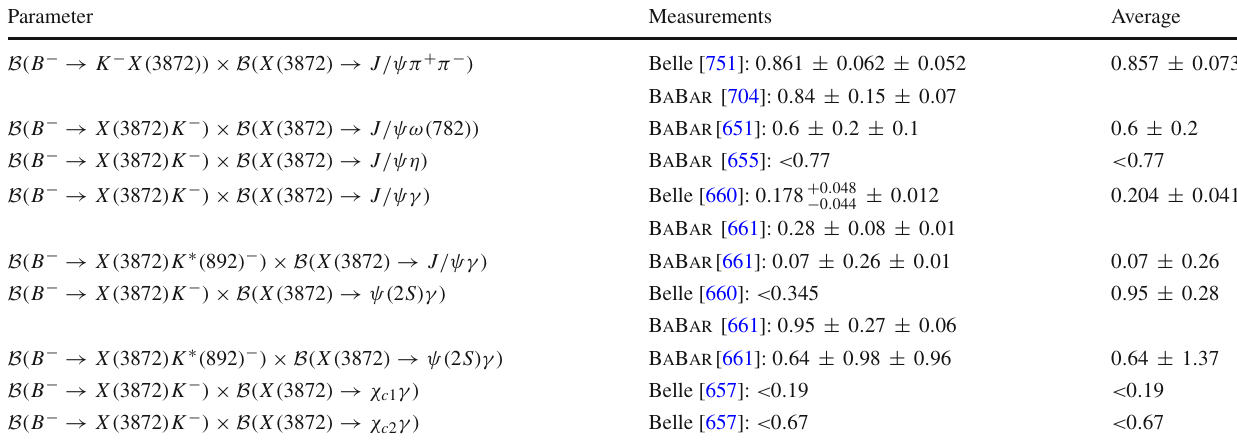
Table 175 Product decay rates to X ( 3872 ) II [ 10 − 5 ]